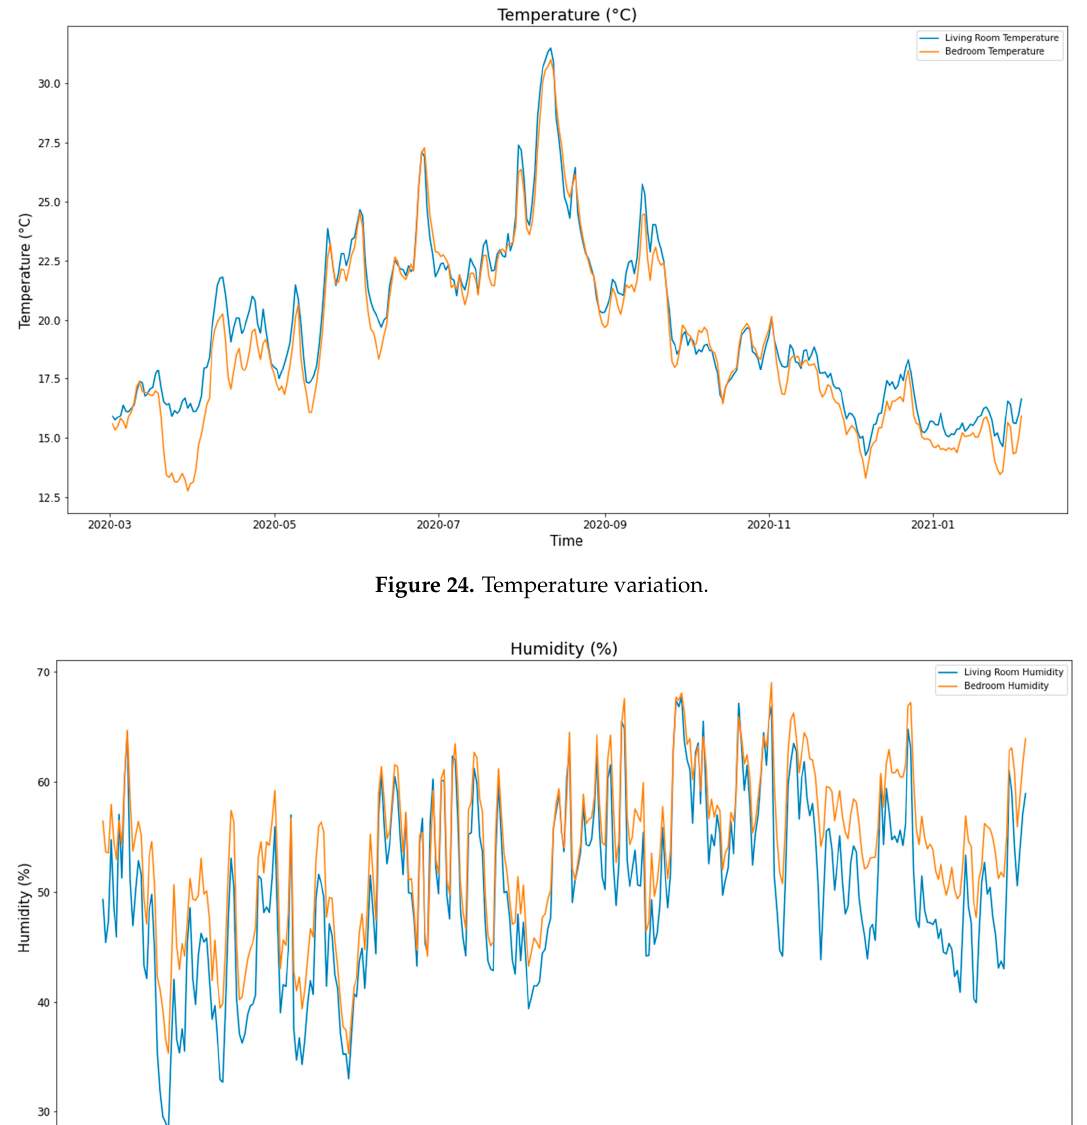
Figure 25. Humidity variation.